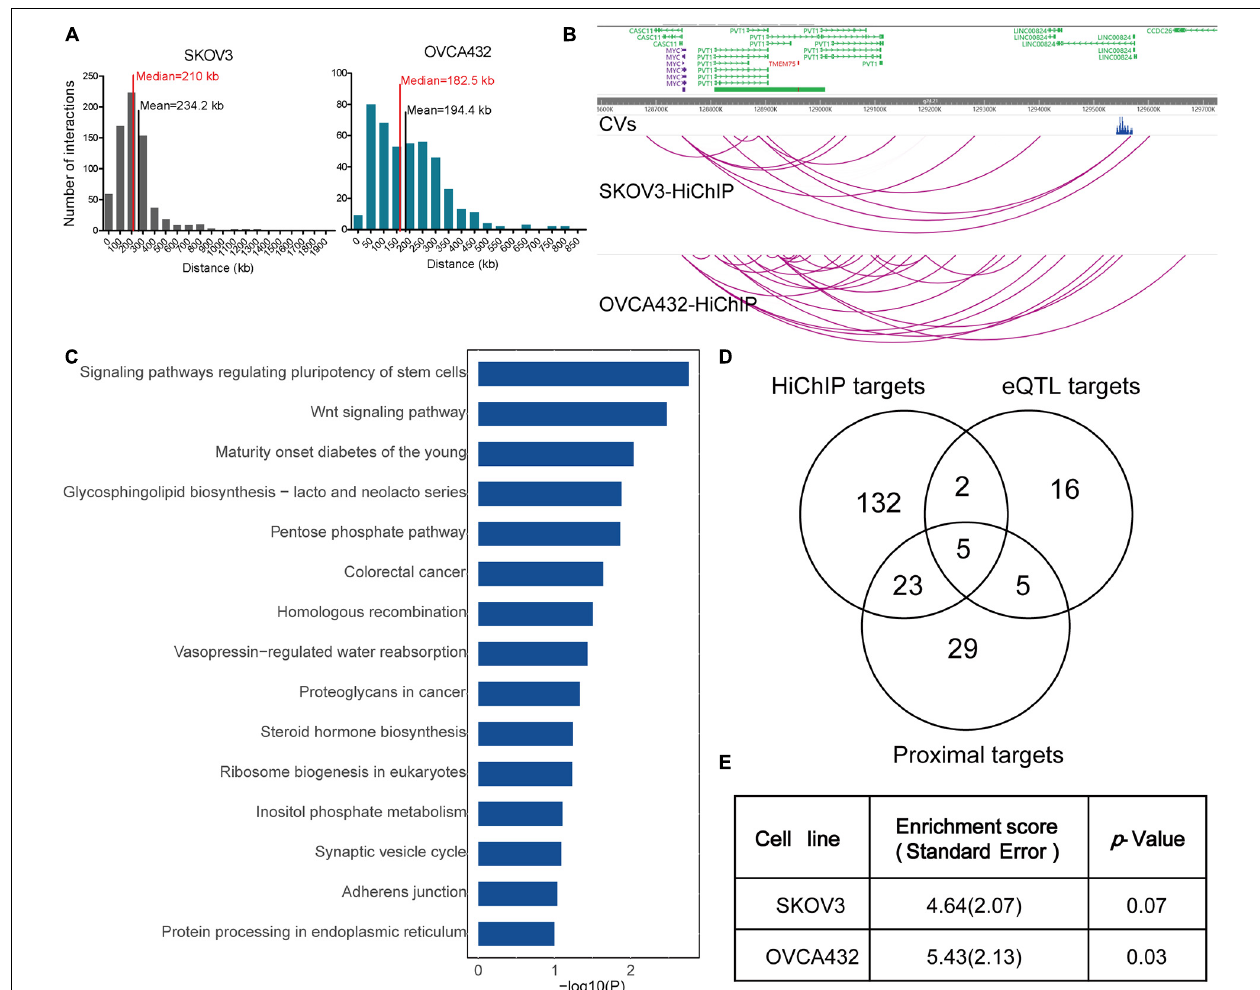
FIGURE 1 | HiChIP identified gene targets for GWAS loci of EOC. (A) Distribution of the distances spanning each CVs involved in the HiChIP loop in SKOV3 and OVCA432. The red line indicates the median distance and the black line indicates the mean distance. (B) Examples of MYC and PVT1 looping to EOC GWAS CVs at 8q21.24 loci. (C) KEGG pathway analysis for HiChIP identified gene targets looping to GWAS CVs. (D) Venn plot displaying the number of HiChIP targets, eQTL targets, and proximal targets of GWAS CVs of EOC. (E) SLDSC enrichment analysis for HiChIP loops identified from SKOV3 and OVCA432